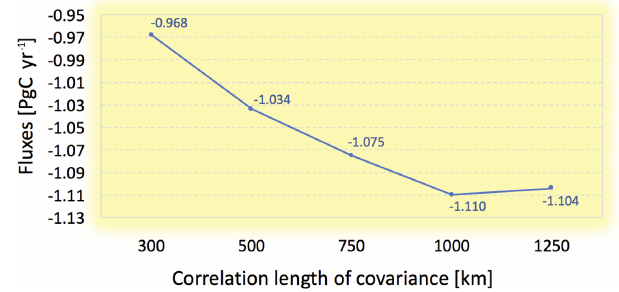
Figure 10. Sensitivity of the optimized annual net biosphere fluxes (PgCyr − 1 ) as a function of the chosen covariance length scale (km). The optimized fluxes tend to converge to − 1 . 1PgCyr − 1 when the length scale is larger than